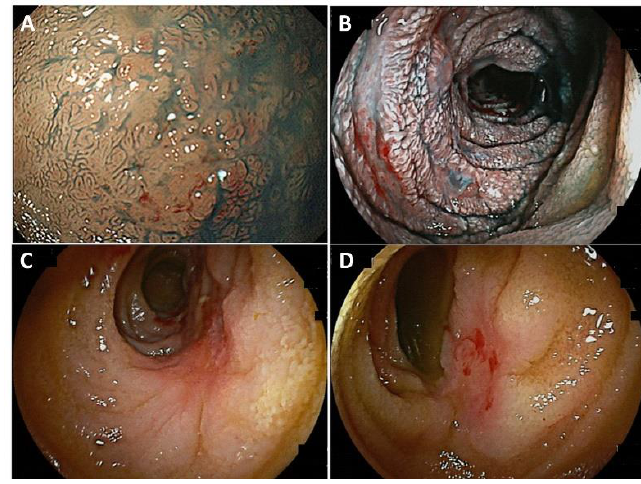
Figure 1. Endoscopic images of small intestinal MALT lymphoma. ( A ) Irregularity of the duodenal mucosa. ( B ) A shallow ulcer with diffuse mucosal edema in the jejunum. ( C , D ) Multiple ulcerated lesions in the ileum.